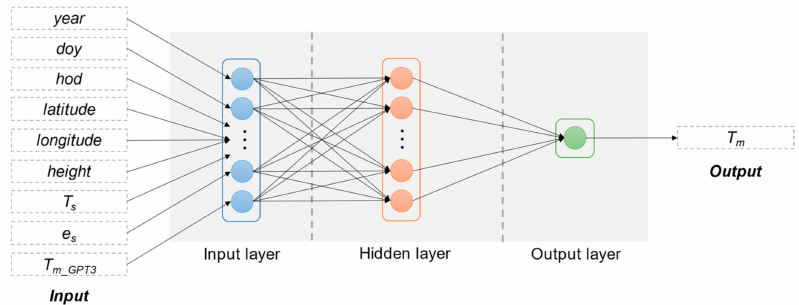
Figure 2. Structure of backpropagation neural network